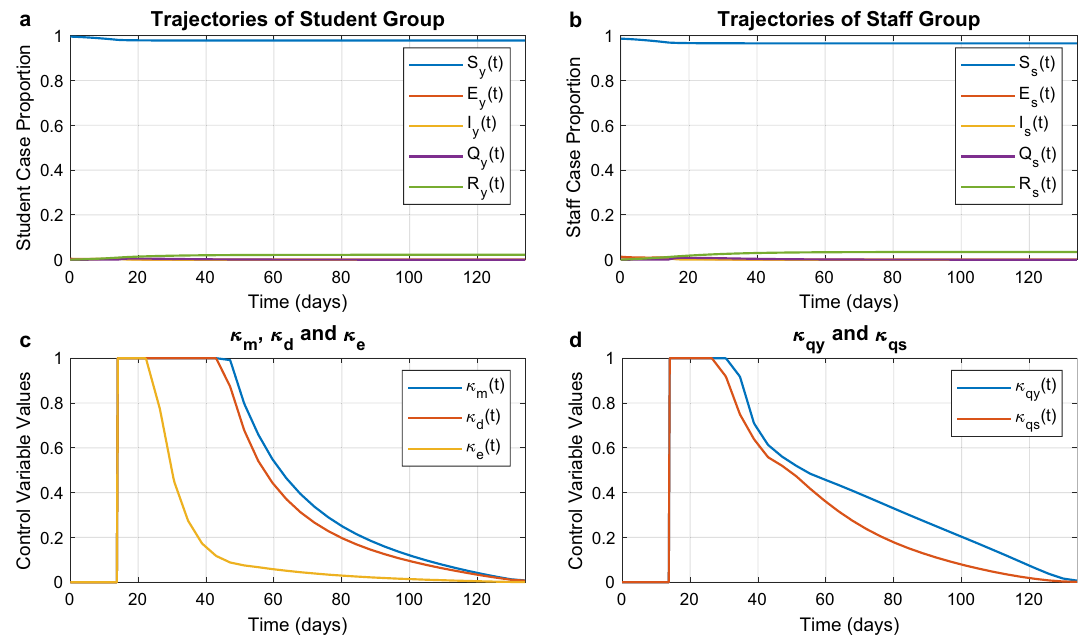
Figure 3. Optimal trajectories for the minimum-case scenario. Optimal trajectories when the department spares no effort to contain the epidemic. ( a ) and ( b ) The epidemic evolution among students and staff, respectively. ( c ) The optimal strategies for mask wearing ( κ m ), social distancing ( κ d ), and environmental disinfection ( κ e ). ( d ) The optimal strategies for mandatory quarantine on infected students ( κ qy ) and infected staff ( κ qs